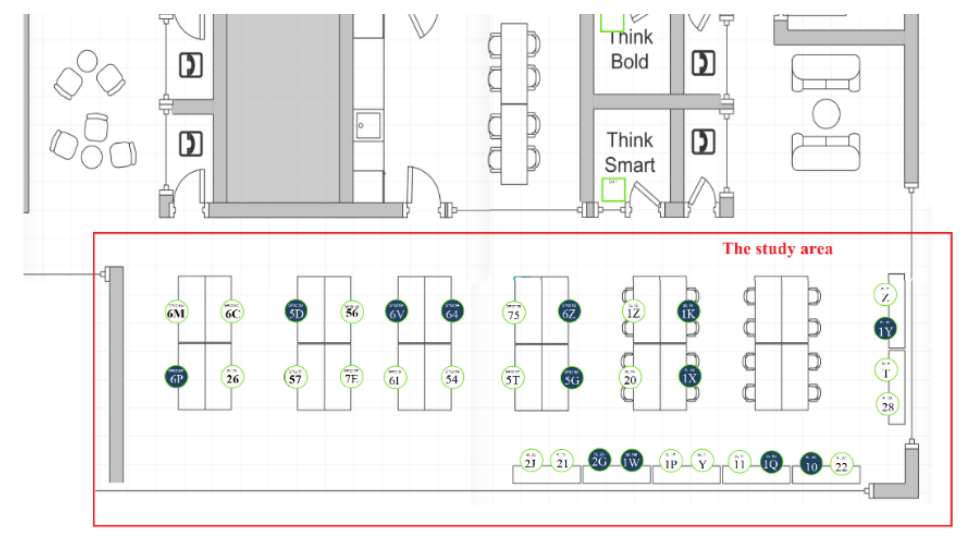
Figure 3. Monitored human occupancy room plan with PIR sensor locations.